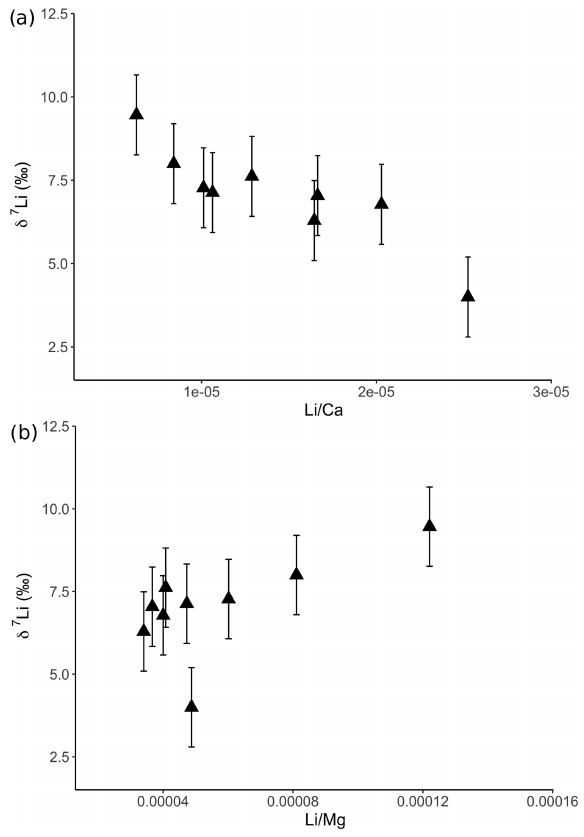
Figure 6. Lithium isotopic compositions of solutions from dolo- stone leaching, as a function of their (a) Li / Ca and (b) Li / Mg ra- tios. Error bars are within the symbol size, if not shown.